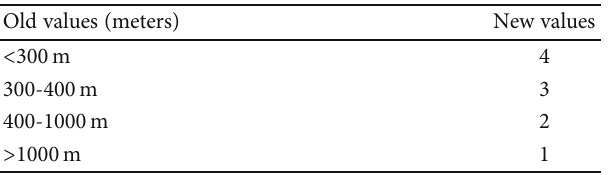
Figure 6: Suitable town distance for solar PV. Table 11: School reclassi fi